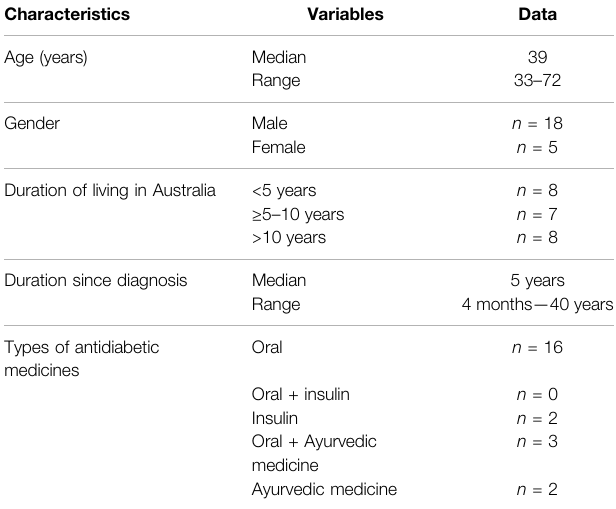
TABLE 1 | Demographic information of participants. Characteristics